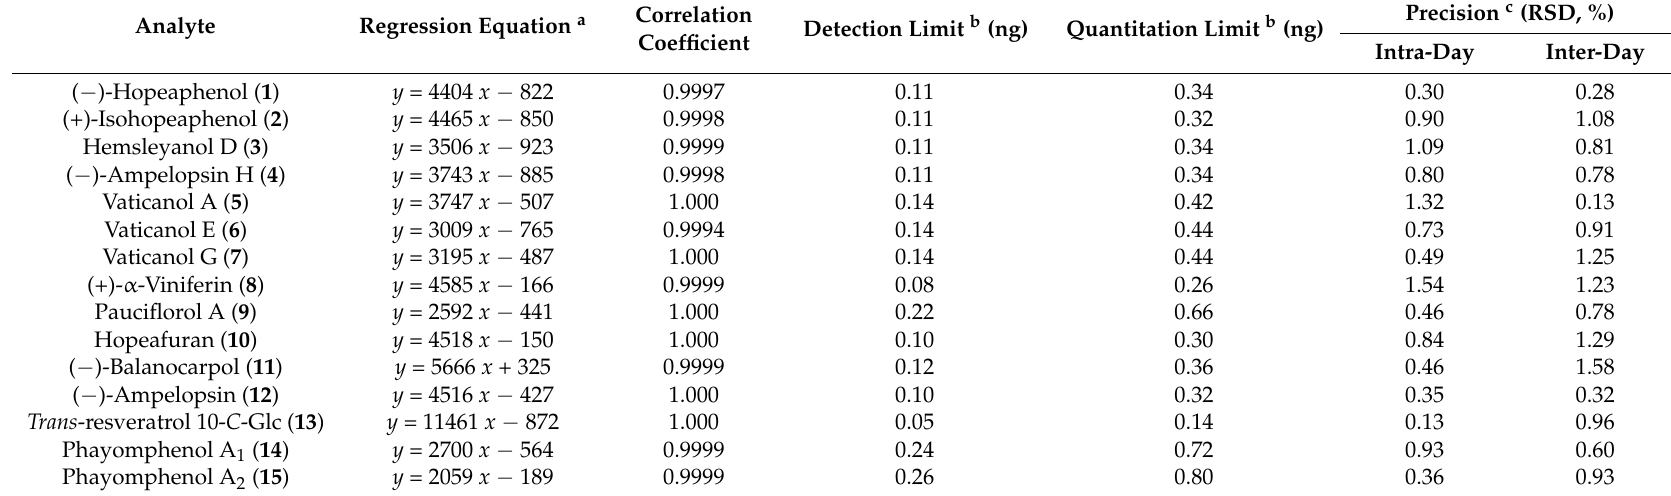
Table 2. Linearities, detection and quantitation limits, and precisions for stilbenoids ( 1 – 13 ) and dihydroisocoumarins ( 14 and 15 ) from the bark of Shorea roxburghii .